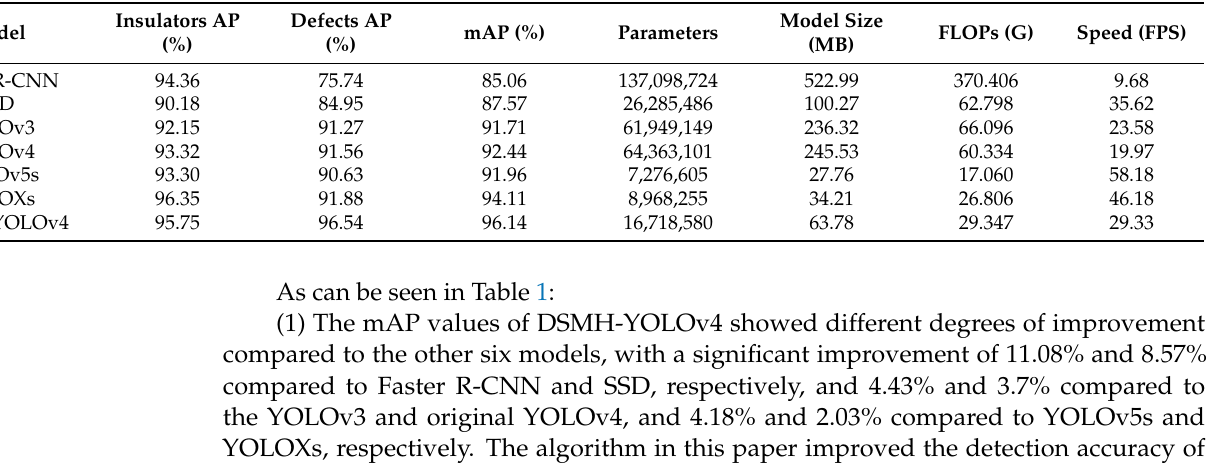
Table 1. Comparison of evaluation indicators of mainstream detection algorithms.